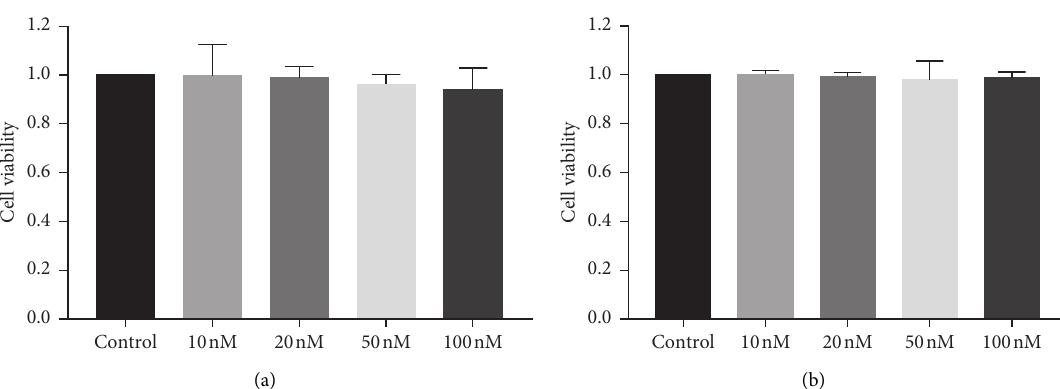
Figure 7: Relative activity of the cells after transfection of different concentrations of I κ B α -siRNA, ranged from 10nM to 100nM. The control group was only transfected with transfection reagent. (a) There was no statistically significant difference in each group for CM cells. (b) There was no statistically significant difference in each group for TM cells.